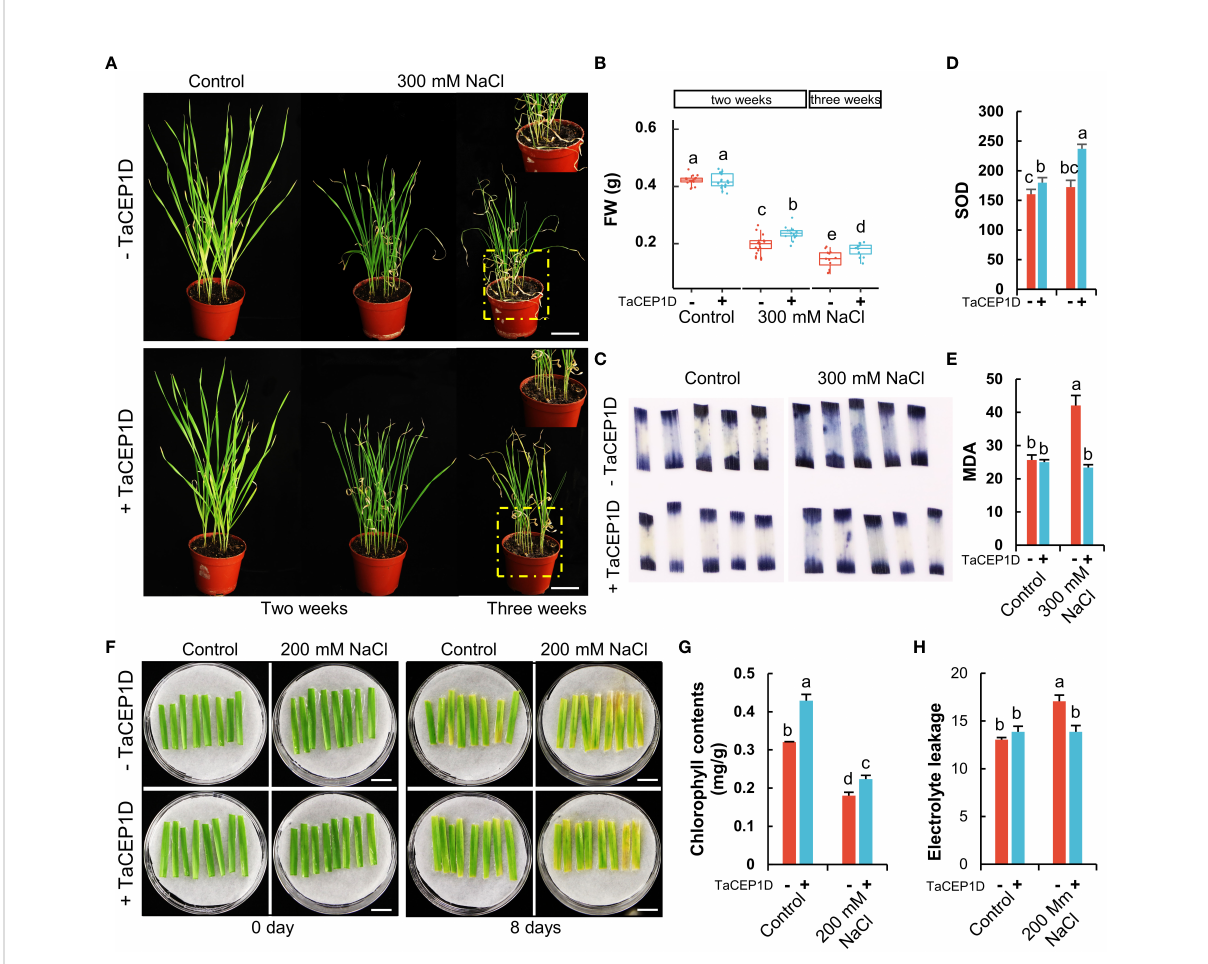
FIGURE 9 Exogenous application of TaCEP1D peptide altered salt stress response in wheat. (A) Wheat plants treated with 0.5 µM TaCEP1D peptide for 2 and 3 weeks under control and 300 mM NaCl conditions. (B) Measurements of fresh weight (FW) of wheat plants from (A) . (C-E) Nitroblue tetrazolium (NBT) staining of O 2- (C) , superoxide dismutase (SOD) activity detection (D) , measurement of molondialdehyde (MDA) contents (E) , respectively. Samples were harvested from the fi rst leaves of plants from (A) . (F) Detached leaves treated with 0.5 µM TaCEP1D peptide for 8 days with 200 mM NaCl. The fi rst leaves were cut from two-week-old wheat plants cultured in Hoagland nutrient solution. (G-H) Measurements of chlorophyll contents and electrolyte leakage of leaves from (G) , respectively. Sample size n = 16 in (B) and 3 in (D, E, G, H) . All statistics analyses were performed with three biological replicates. Lowercase letters in (B, D, E, G, H) indicate statistically signi fi cant difference based on Student ’ s t- test ( p < 0.05). Bar = 5 cm in (A) , and 1 cm in (F)